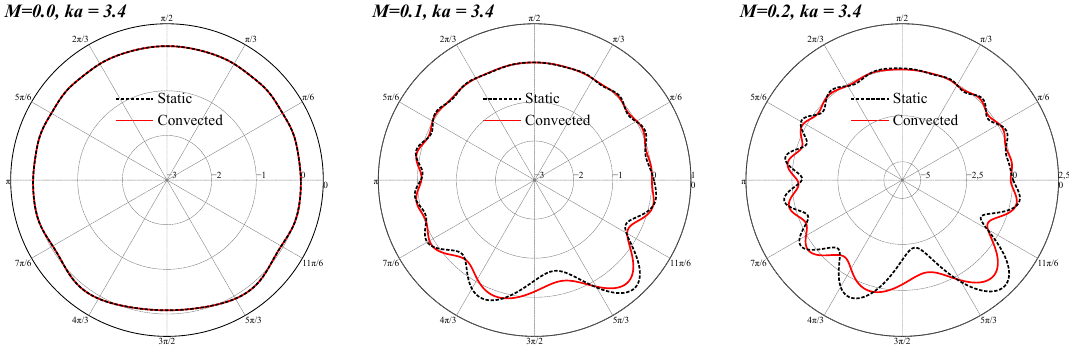
for ka = 3.4 (Equation (5)). L